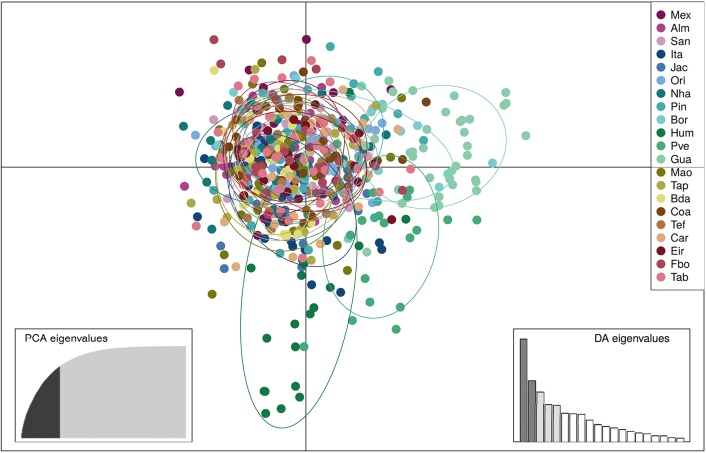
Results of the Discriminant Analysis of Principal Components (DAPC) showing the scatterplot of the first two principal components based on 13 microsatellite loci of 604 individuals of Colossoma macropomum from 21 sampling locations. Discriminant function 2 on the x axis and discriminant function 1 on the y axis. In the DAPC graph circles represent different individuals, and colors different sampling localities. Locality codes are: Mexiana (Mex), Almeirim (Alm), Santarém (San), Itaituba (Ita), Jacareacanga (Jac), Oriximiná (Ori), Nhamundá (Nha), Parintins (Pin), Borba (Bor), Humaitá (Hum), Porto Velho (Pve), Guajará-Mirim (Gua), Manaus (Mao), Tapauá (Tap), Boca do Acre (Bda), Coari (Coa), Tefé (Tef), Carauari (Car), Eirunepé (Eir), Fonte Boa (Fbo), Tabatinga (Tab).